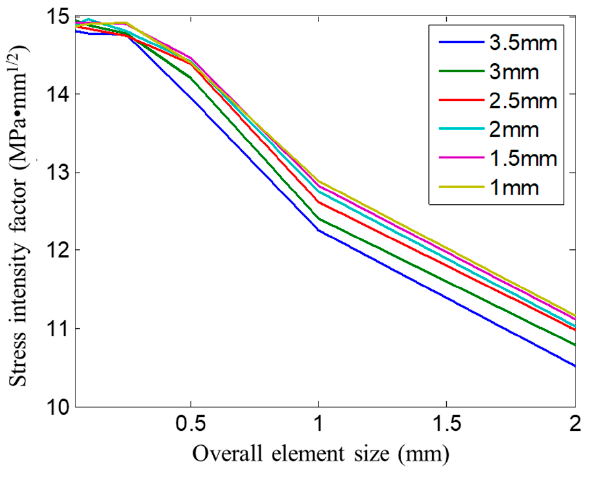
Figure 2. Effect of overall element size on stress intensity factor.